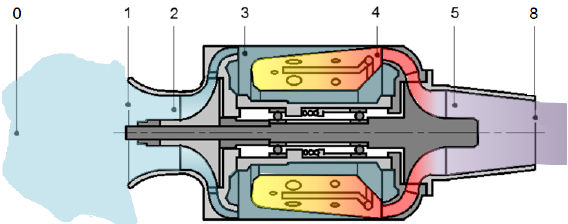
Figure 1. Longitudinal section and important aerodynamic stations of PD-60R micro turbojet